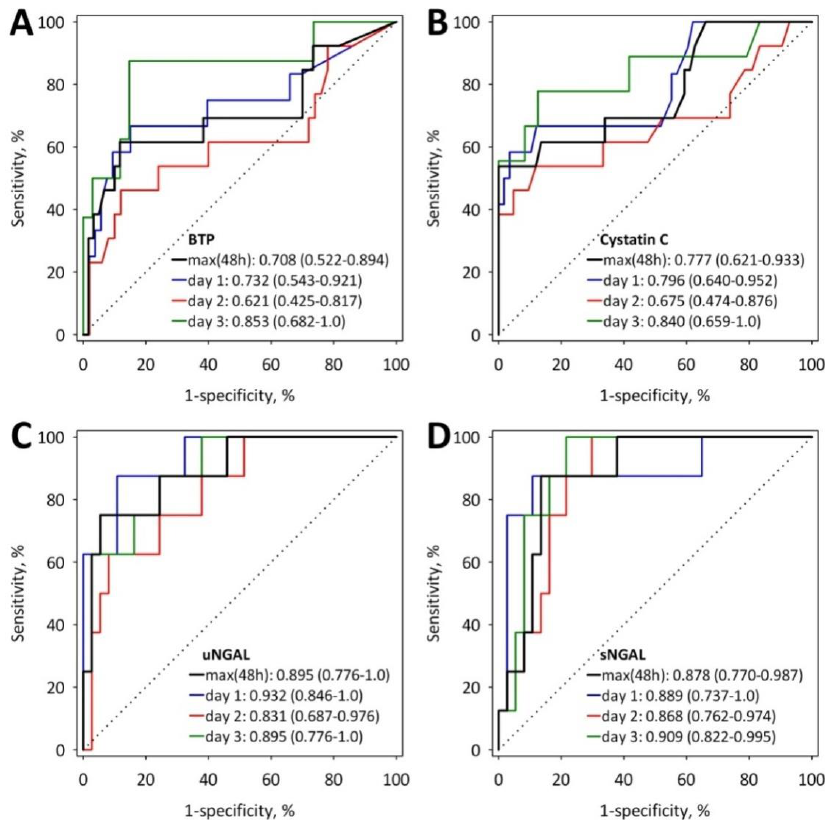
Figure 3. ROC curves showing the diagnostic accuracy of serum BTP ( A ), cystatin C ( B ), urine